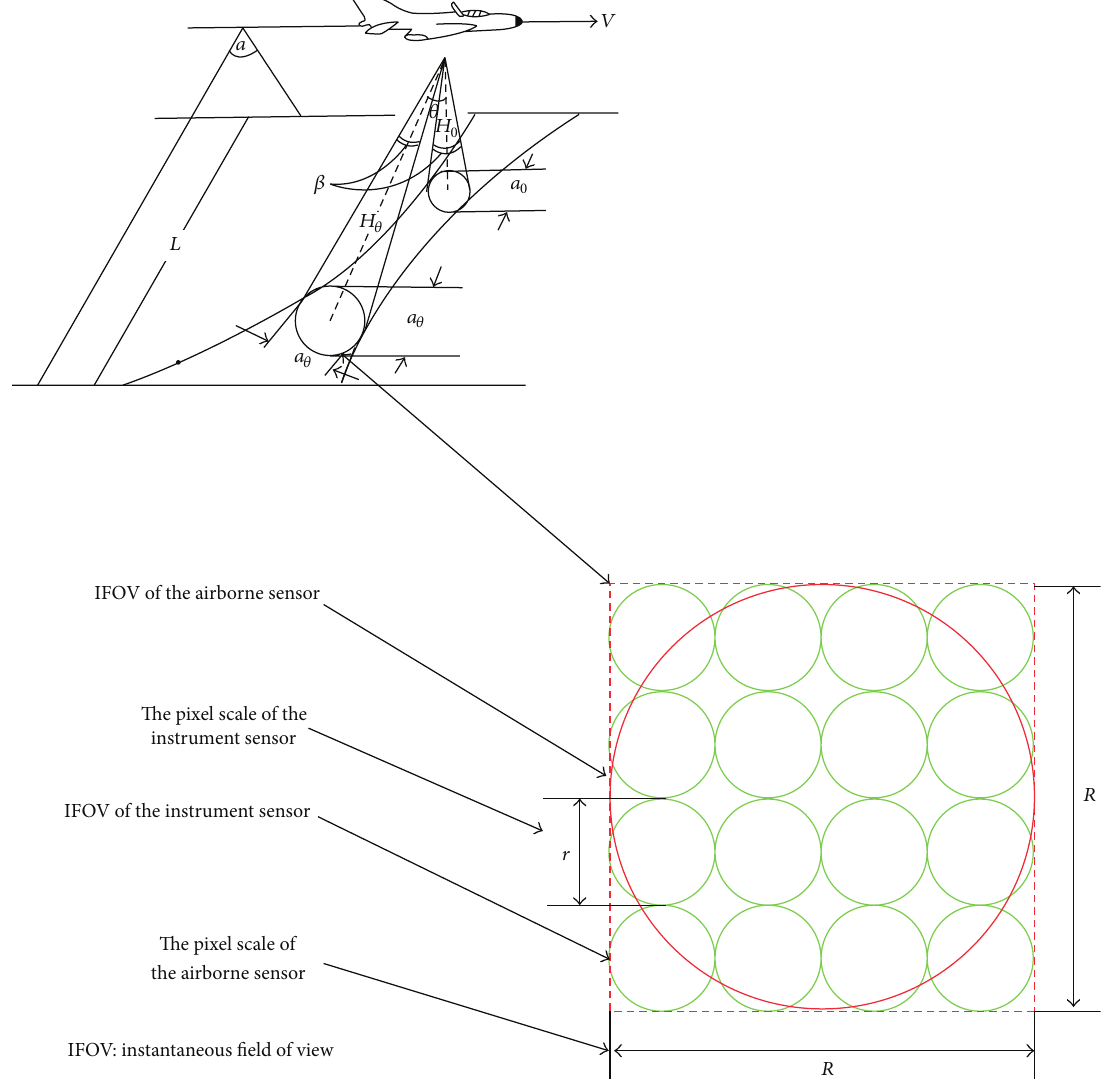
Figure 1: The schematic sketch of scanning